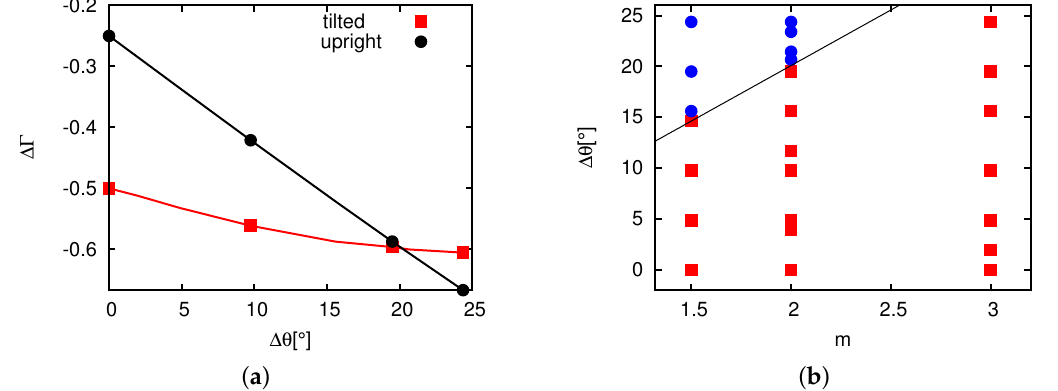
Figure 5. ( a ) The dimensionless free energy ∆Γ (see Equation (28)) is shown for the tilted state as well for the upright state for m = 2. A transition point is found at ∆ θ t ≈ 20 ◦ . For ∆ θ < ∆ θ t , the tilted state minimizes the free energy. The upright state minimizes the free energy above ∆ θ t . ( b ) The regions in the m - ∆ θ phase diagram, where the tilted and upright state minimize the free energy, are shown by squares and circles, respectively. The black line separates both